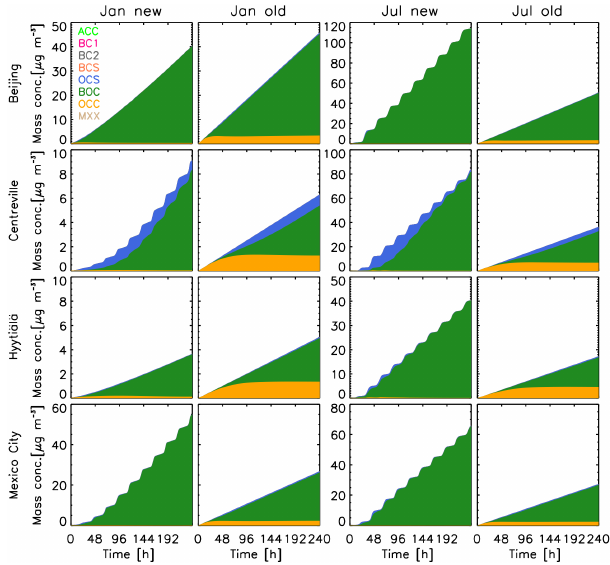
Figure 4. Temporal evolution of organic aerosol mass concentration in each organics-containing population from the new scheme (first column for January, third column for July), and the old scheme (sec- ond column for January, fourth column for